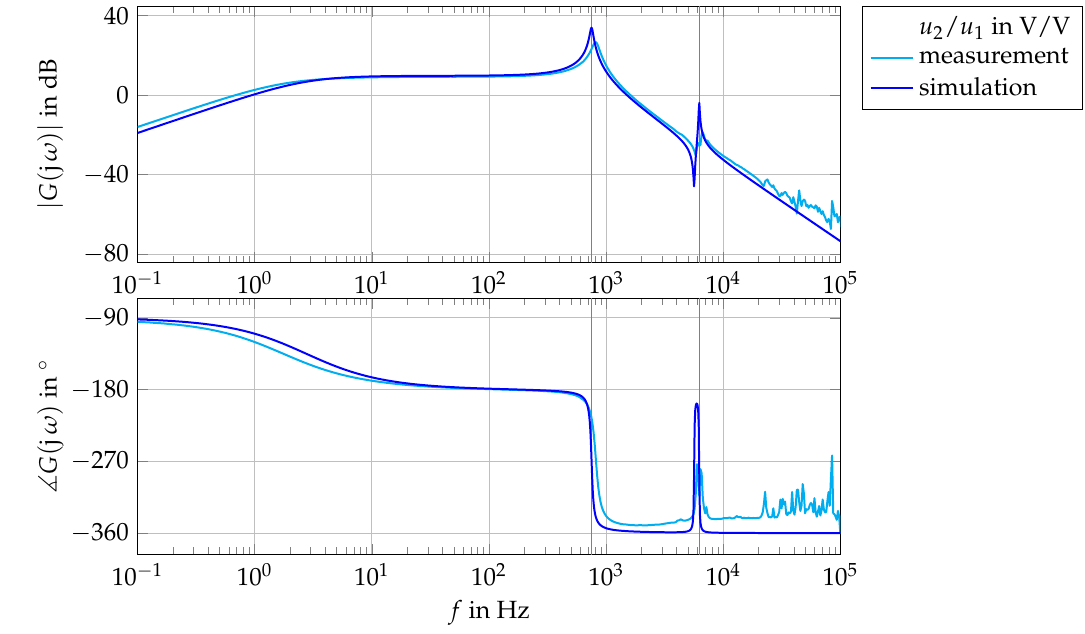
Figure 11. Comparison between the modelled and measured frequency responses of the system with no mechanical load